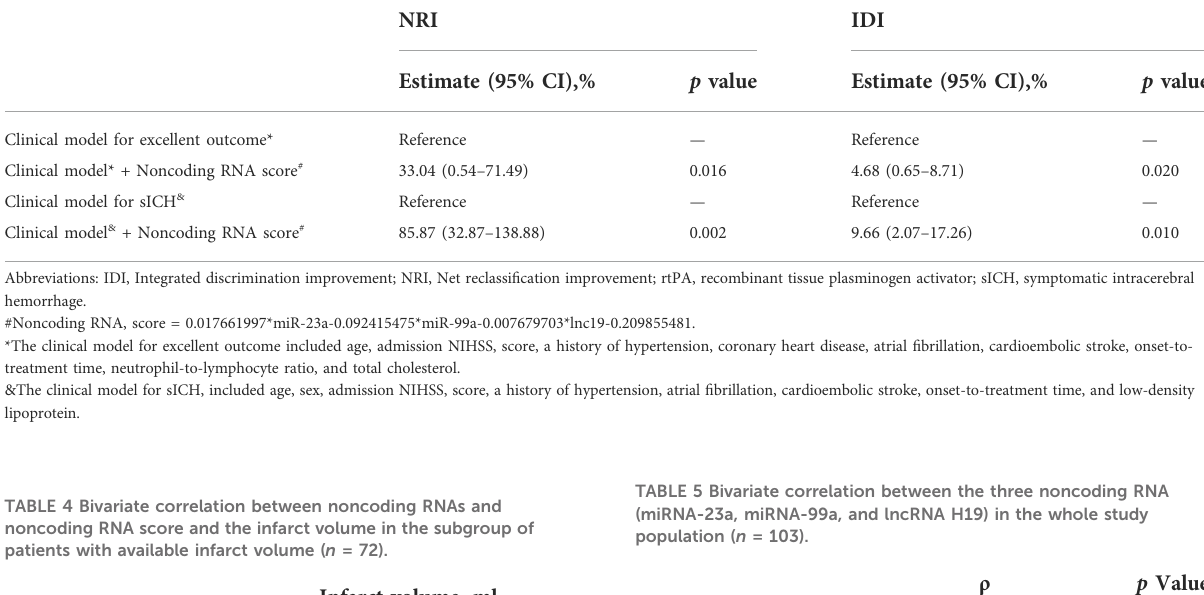
TABLE 5 Bivariate correlation between the three noncoding RNA (miRNA-23a, miRNA-99a, and lncRNA H19) in the whole study population ( n =